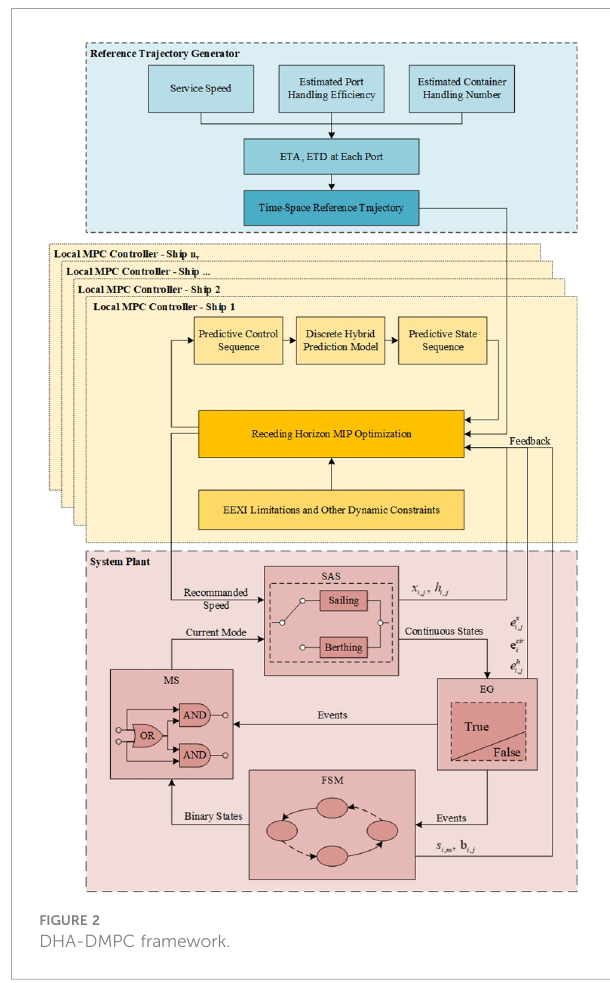
FIGURE 2 DHA-DMPC